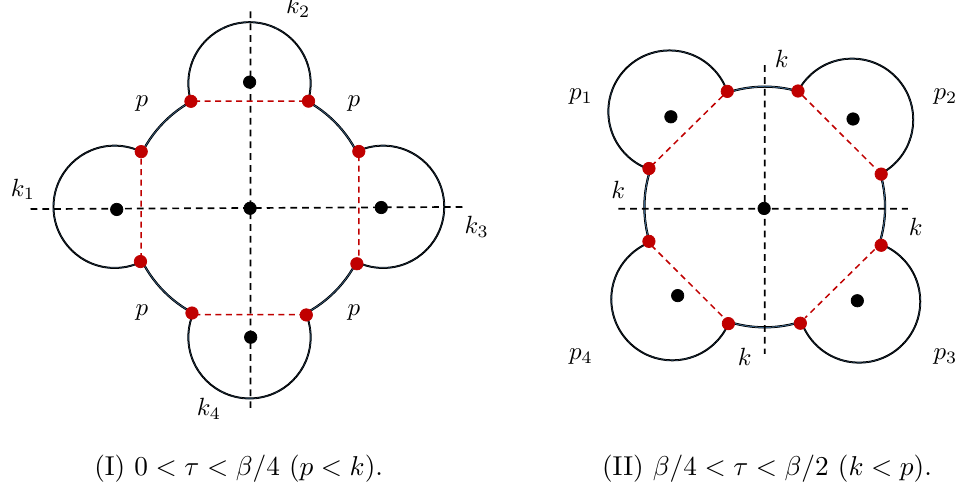
Figure 8 . Geometry generated by the insertion of heavy operators (red dots) for n = 4 (replicas are separated by dashed lines). Case I: four local dilaton local minima at the horizons (black dots) with (cid:8) i / k i ( n ) (cid:17) k ( n ) and at the central, (global) minimum Z n symmetric, horizon with (cid:8) min / p ( n ) < k ( n ). Case II: four local minima at the horizons (black dots) with (cid:8) i / p i ( n ) = p ( n ) and at the Z n symmetric horizon with (cid:8) min / k ( n ) < p ( n